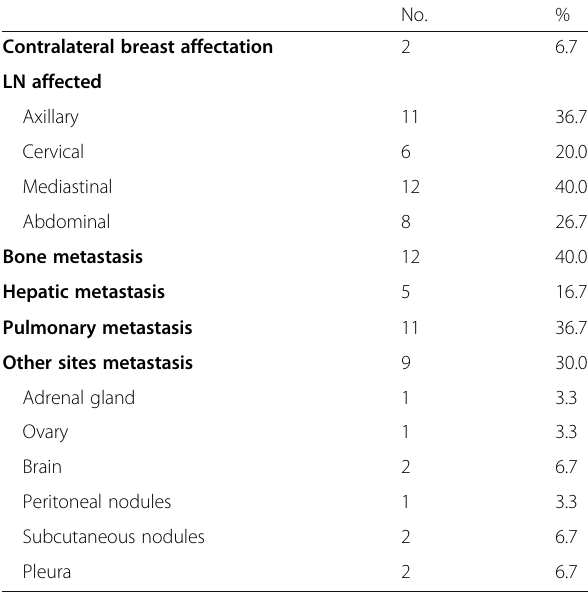
Table 1 Contralateral breast affectation, lymph nodes, and other metastasis among breast cancer patient by PET/CT